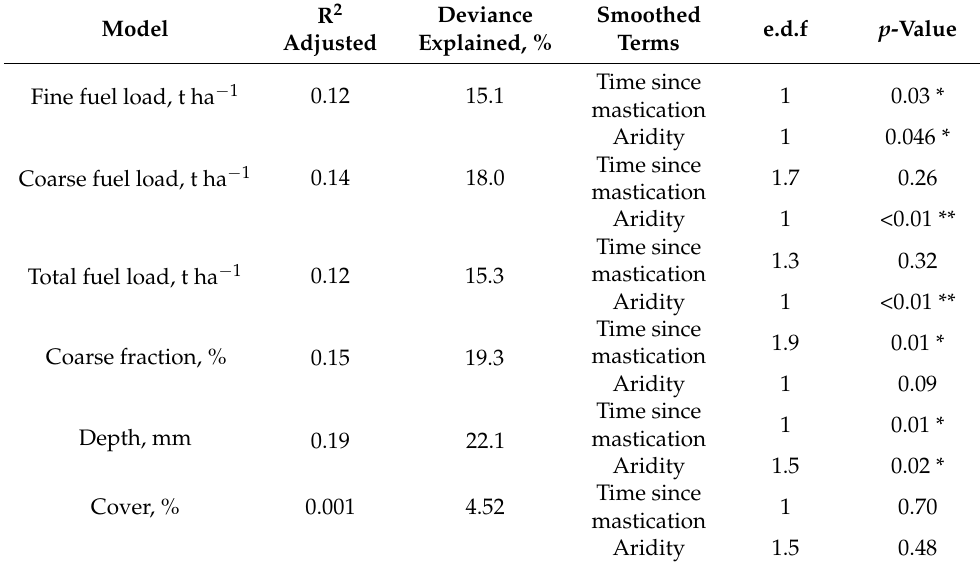
Table 2. Diagnostics of the GAMs fitted to the surface fuel properties with time since mastication and aridity as smoothed predictor variables. e.d.f. = effective degrees of freedom. Statistical significance denoted by * p < 0.05; and ** p < 0.01. Deviance Smoothed R 2 e.d.f p -Value Model Explained, % Terms Adjusted Fine fuel load, t ha − 1